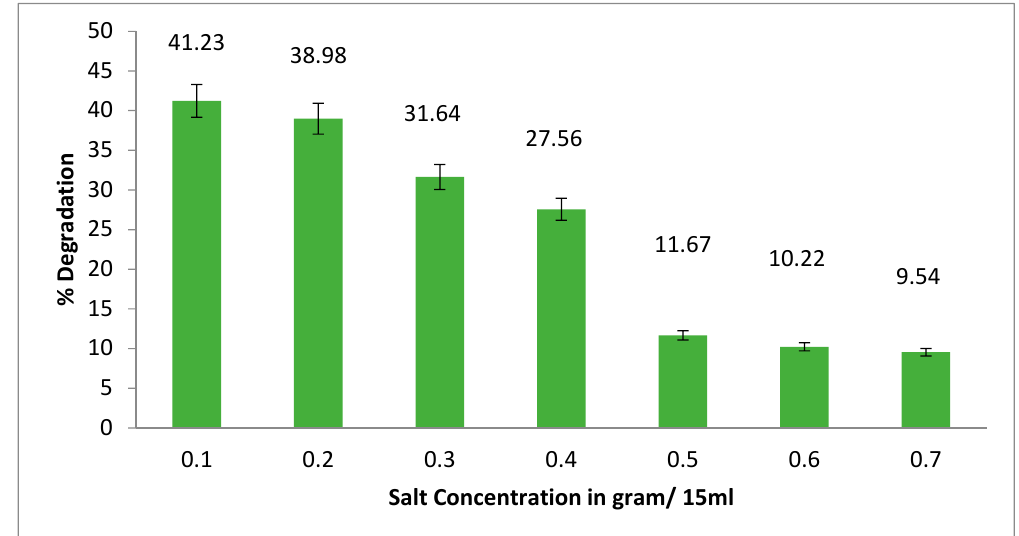
Figure 7. Salt concentration on % degradation of brown 706.